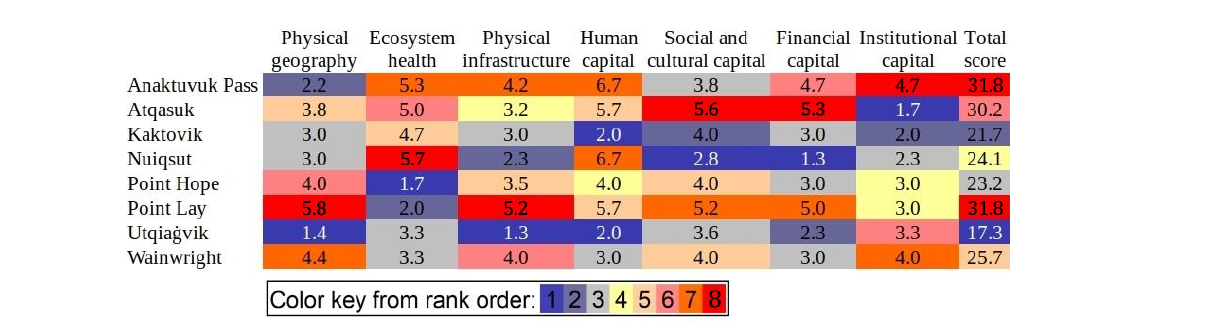
Fig. 3 . Normalized rank scores and total rank of adaptive capacity (AC) among eight North Slope communities: average ranking across all measures in each domain and sum of rankings (total score) across all domains: 1 = highest, 8 =